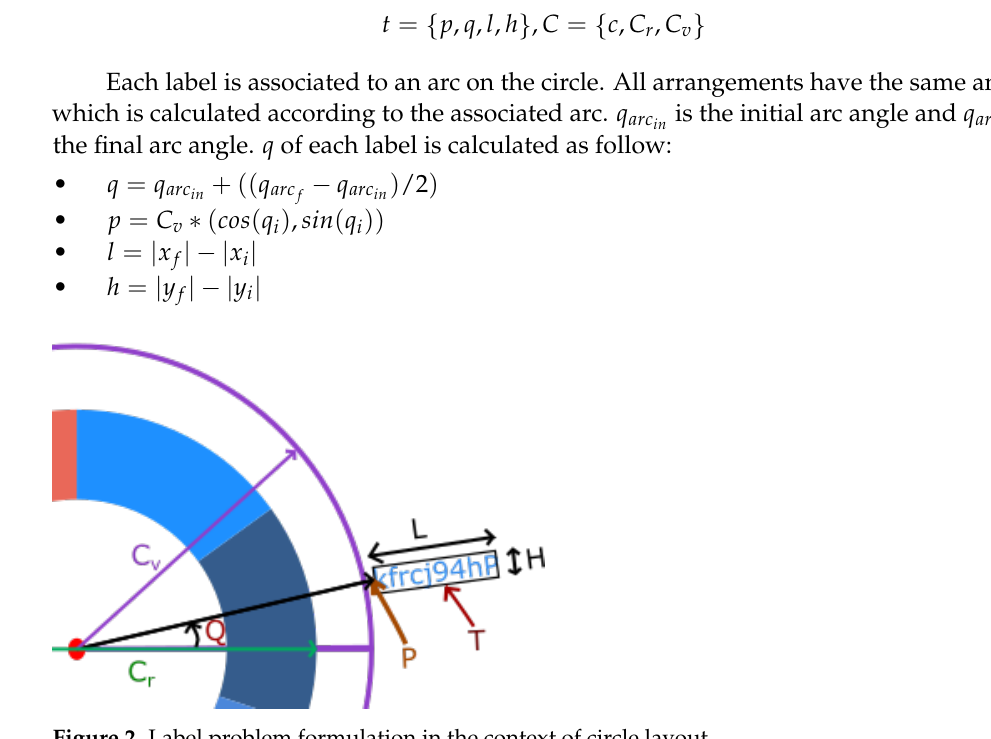
Figure 2. Label problem formulation in the context of circle